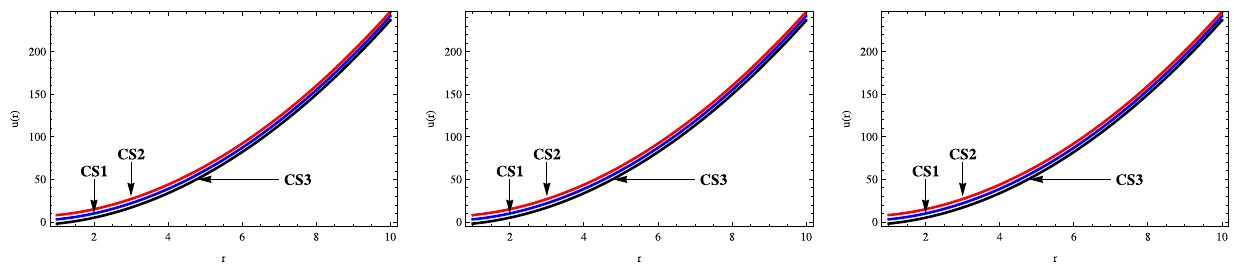
Fig. 19 Variations of u ( r ) versus r (km) with the numerical values of A , B and C from Tables 2, 3 and 4 respectively